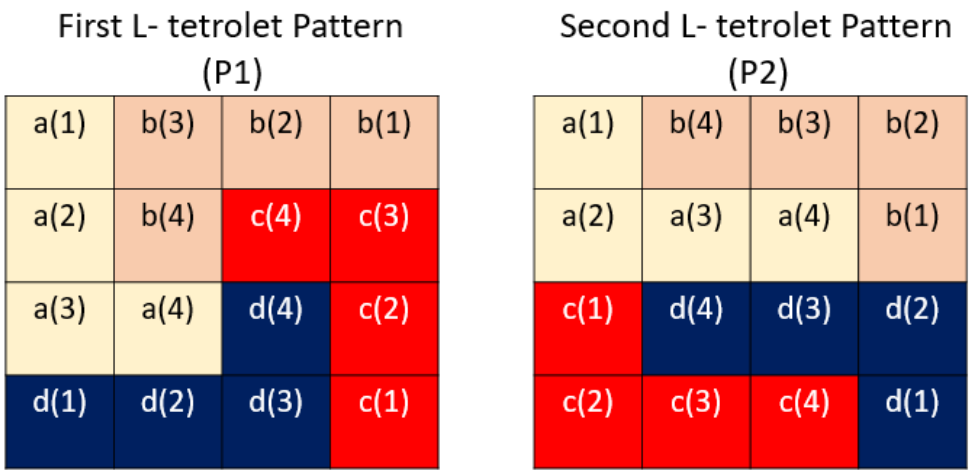
Figure 2. The 4 × 4 matrix that was created for applying the proposed L-tetrolet pattern. Step 2.3: Use two L-tetrolet based patterns by employing the 4 × 4 sized matrix. Figure 3 shows the L-tetrolet patterns that were used for feature generation.